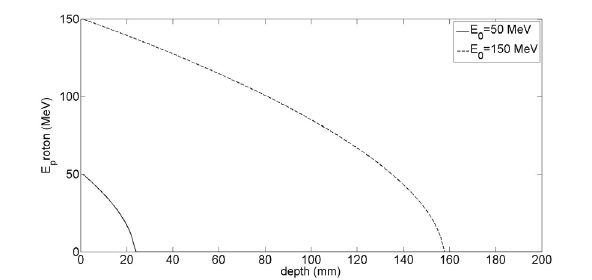
Fig 2. Protons energy as a function of depth in water for 50 MeV (solid line) and 150 MeV (dashed line) E 0 .